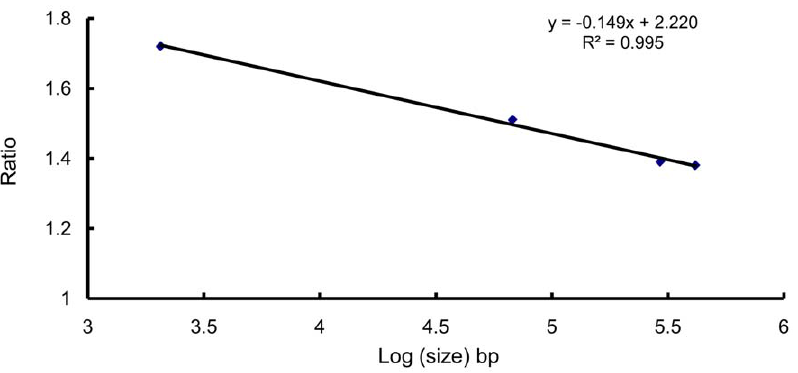
Figure 3. Relationship between the ratio of PCN and plasmid size. The ratio denotes the PCN of pBMB2062, pBMB67, pBMB293, and pBMB400 at the mid-exponential growth stage to that at the spore stage. The ratios of PCNs are also shown in Table